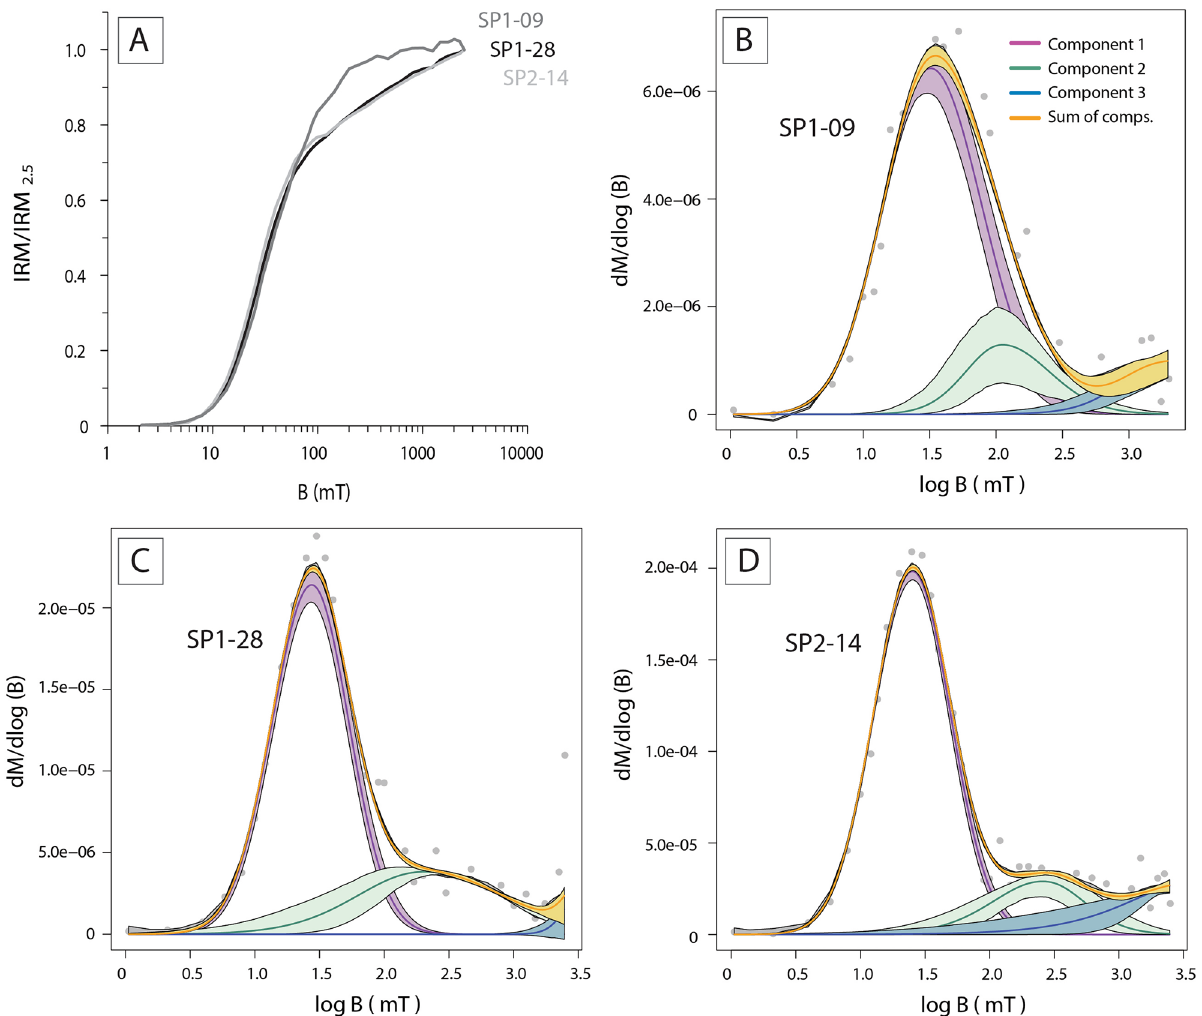
Figure 2. ( A ) Normalized isothermal remanent magnetization (IRM) acquisition curves of the SP stalagmite. ( B–D ) Skewed generalized log-Gaussian function of representative SP samples obtained with the MAX UnMix software showing the presence of three magnetic components, assigned to be magnetite, hematite, and goethite,